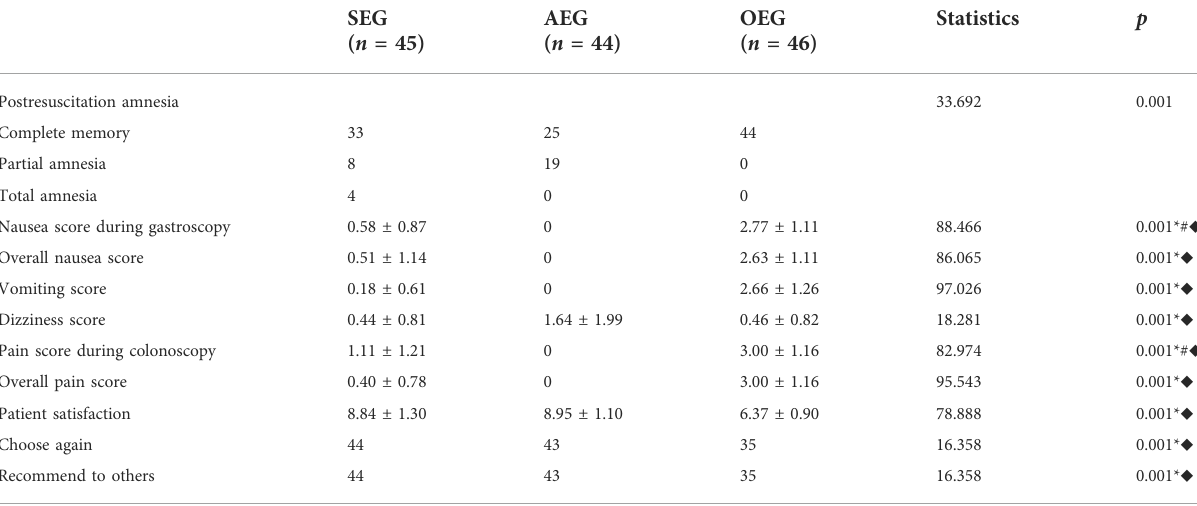
TABLE 4 Comparison of patient tolerability among the different groups ( ‾ χ